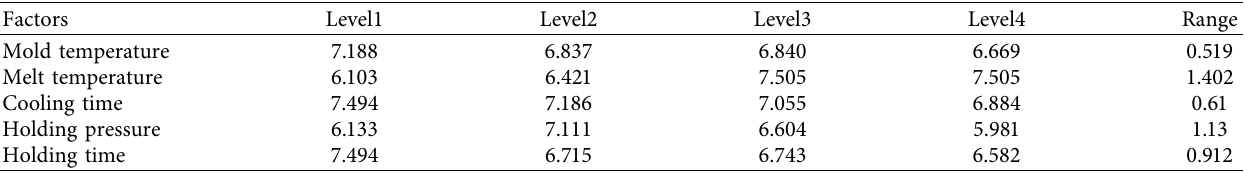
Figure 15: Volume shrinkage range analysis line chart. Table 7: Analysis of range of warpage deformation.